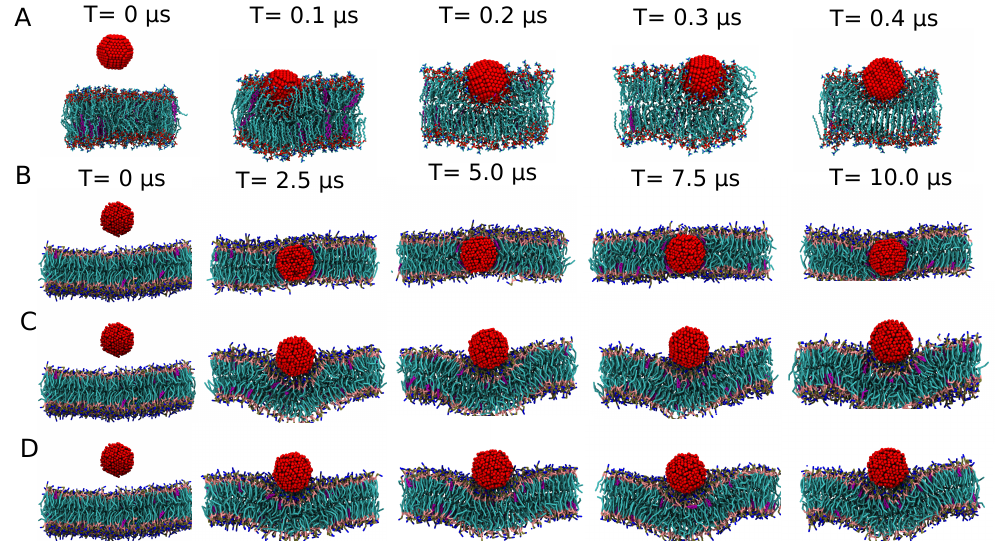
Figure 3. Selected snapshots showing the evolution of a 3 nm NP interacting with a lipid membrane composed of DPPC, DOPC, POPC and cholesterol in 5:2:2:1. Different resolutions and different CG bead type combinations in the core-shell model are shown: ( A ) for the reference all-atom representa- tion of an Ag NP, ( B ) uniform C C 5 -S C 5 CG representation, ( C ) uniform C C 2 -S C 2 CG representation and ( D ) target C C 5 -S C 2 CG representation of an Ag NP. As the nature of the lipids is not crucial at this stage, all lipids are shown as blue sticks and cholesterol in pink sticks, while each atom (AAMD) or bead (CGMD) in the NP is represented with a red sphere. The reference snapshots of unconstrained AAMD—see panel A—were obtained in a previous atomistic study for a smaller system [35] and are only added here to enable a direct visual comparison to the new CGMD